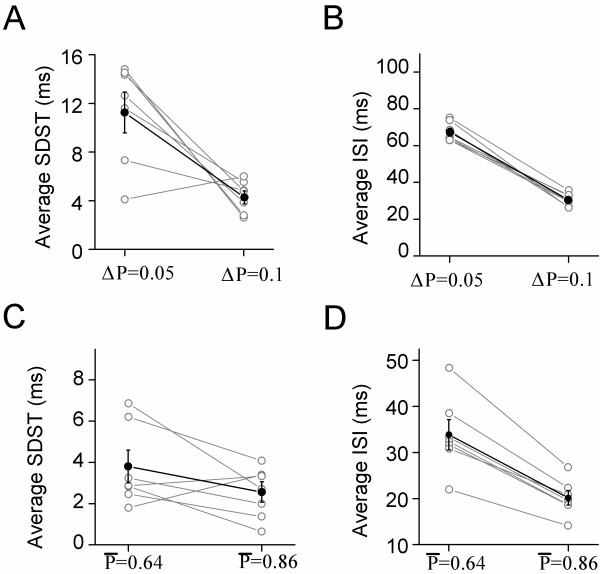
Release probability increment and higher release probability enhance spike encodings at postsynaptic GABAergic neurons. A) The higher increment of release probability during presynaptic sequential spikes reduces SDST. B) The higher increment of release probability during presynaptic sequential spikes reduces ISI. C) The higher release probability reduces SDST. D) The higher release probability reduces ISI.